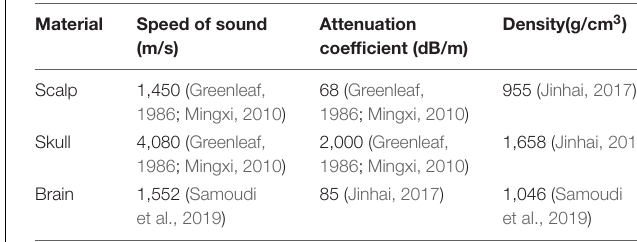
Frontiers in Neuroscience |